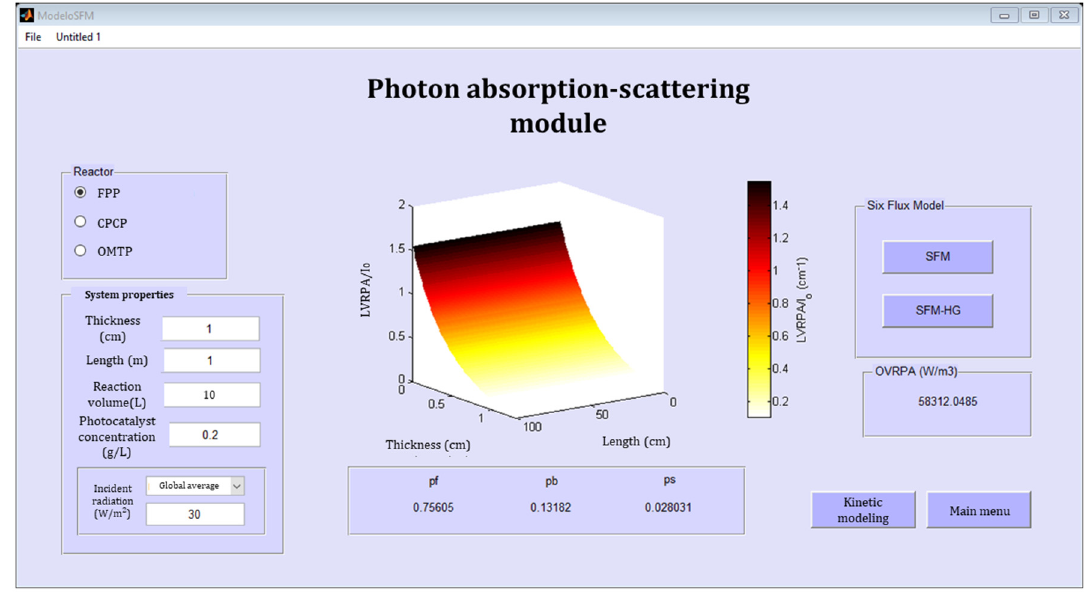
Figure 9. Radiation field simulation of a flat plate photoreactor (FPP) with SFM-HG.